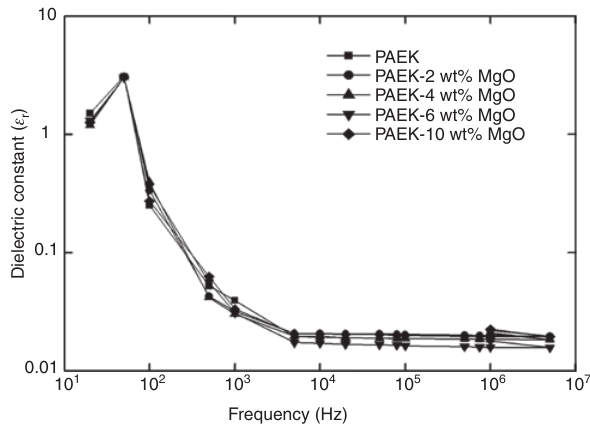
Figure 4: Effect of temperature on dielectric constant for PAEK-MgO